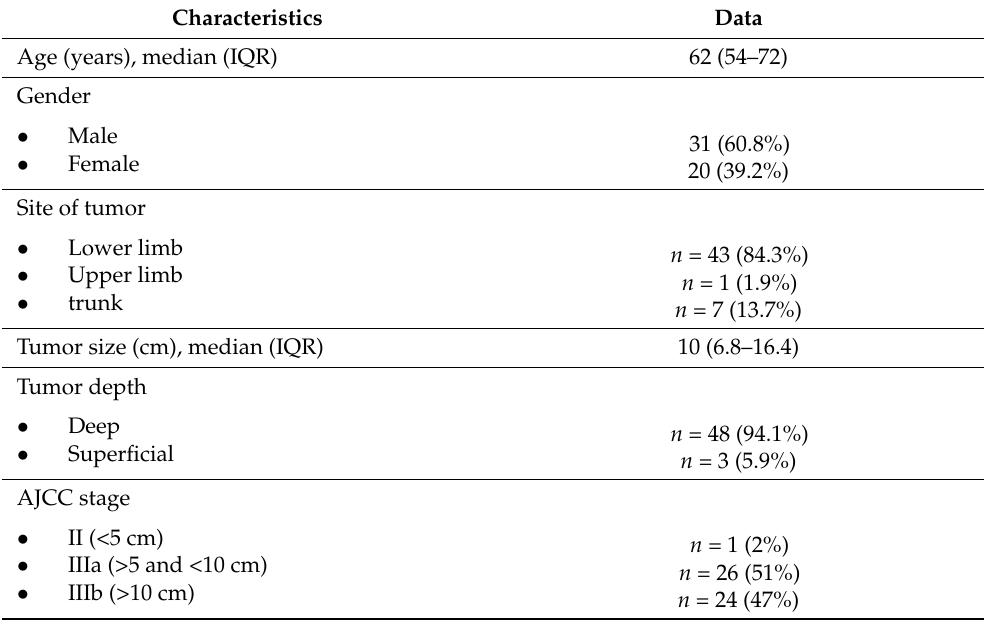
Table 1. Patient demographics and clinical